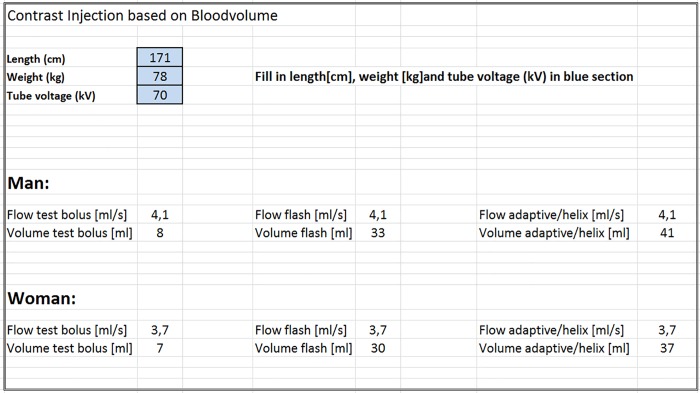
Example of excel file used to calculate the individual patient’s injection protocol.Patient characteristics where inserted in the blue cells, the excel file calculated the needed injection protocol.